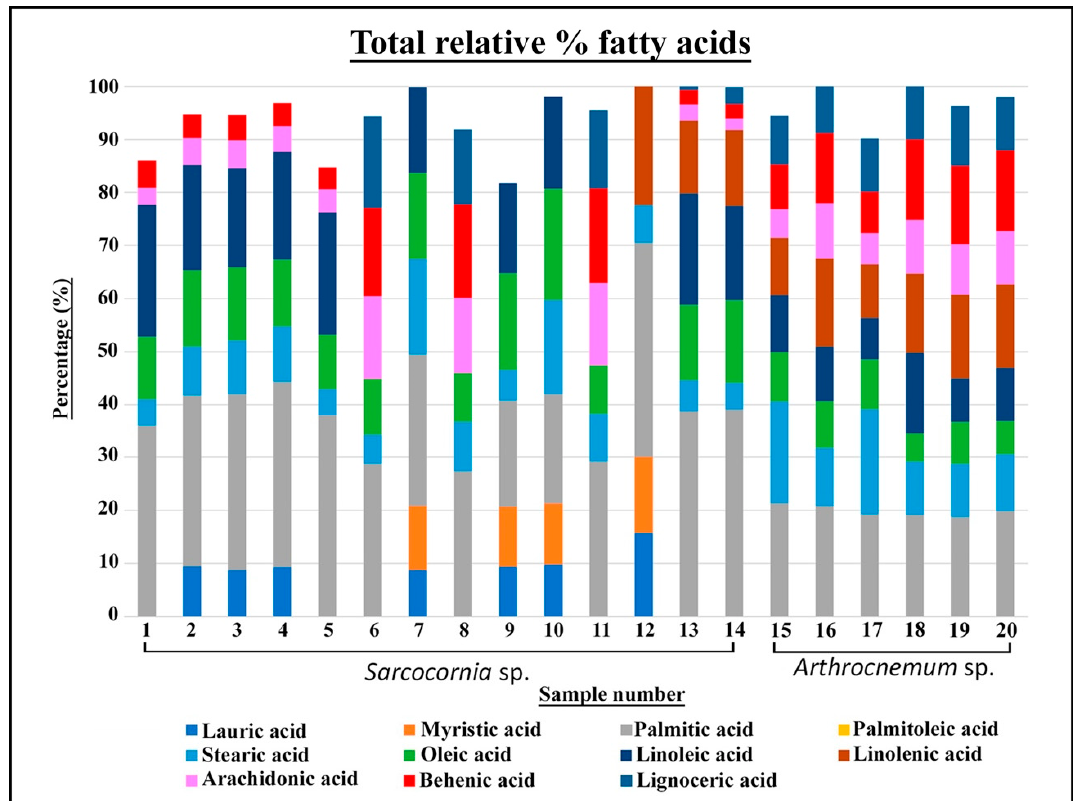
Figure 4. Total relative percentages of the fatty acids.